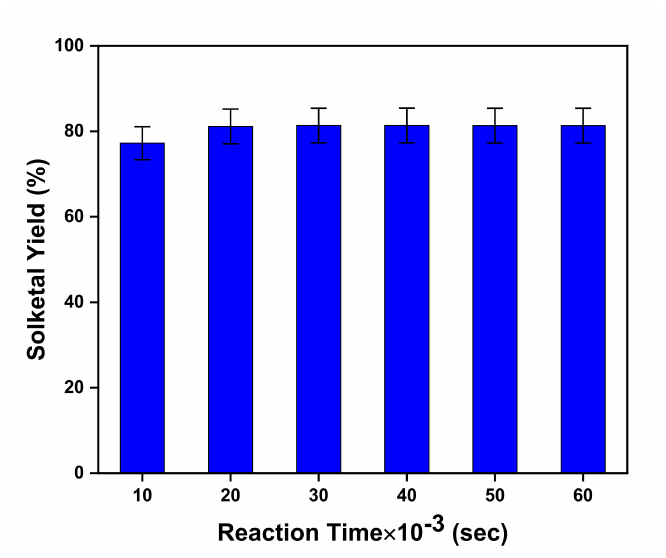
Figure 7. Effect of reaction time on solketal